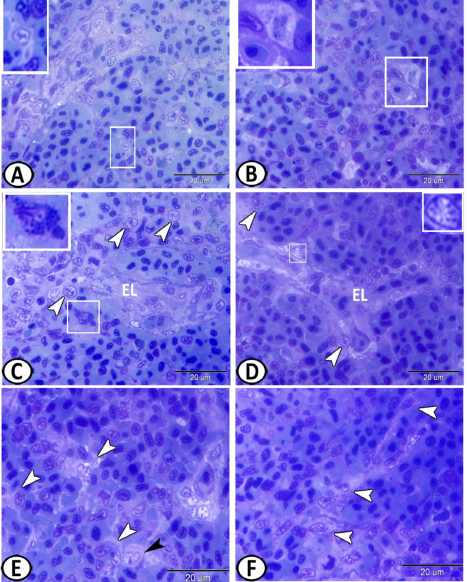
Figure 3. Semithin sections of the spleen stained with toluidine blue. ( A , B ) neurons (boxed areas) were observed in the splenic parenchyma. ( C ) Mast cells with characteristic metachromatic granules (boxed areas) and rodlet cells (arrowheads) were present among the splenic cells. ( D ) Rodlet cells (arrowheads, boxed areas) were distributed around the ellipsoids (EL). ( E , F ) Many branched epithelial reticular cells (white arrowheads) and monocytes (black arrowheads) were identified in the spleen. The spleen was innervated by autonomic sympathetic fibers (splanchnic